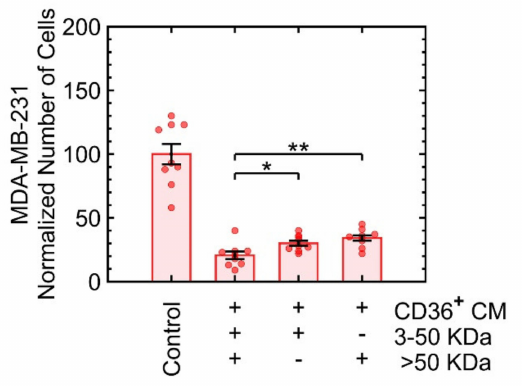
Figure 5. Proteins in the range 3–50 KDa or larger than 50 KDa induce growth suppression in MDA-MB-231. * p < 0.05, ** p <